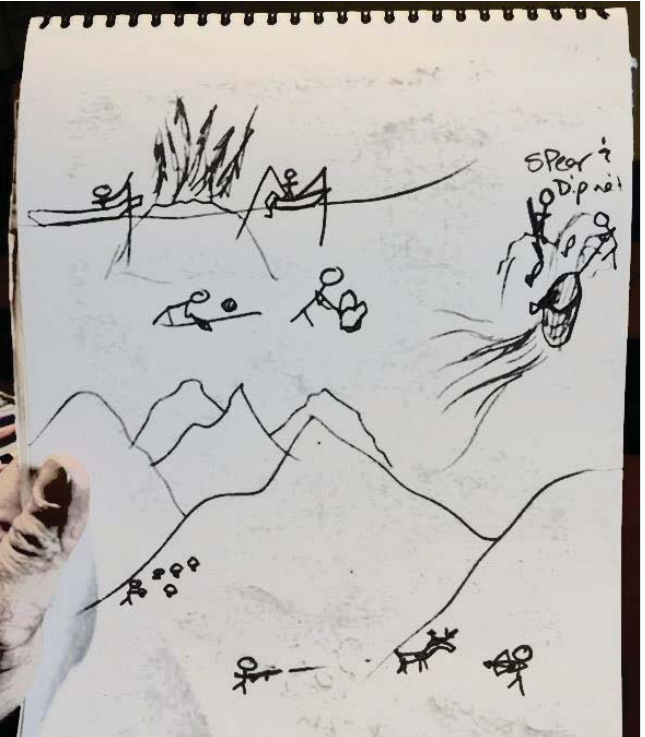
Figure A7 .3: Sample depiction of local ambit: First Nations